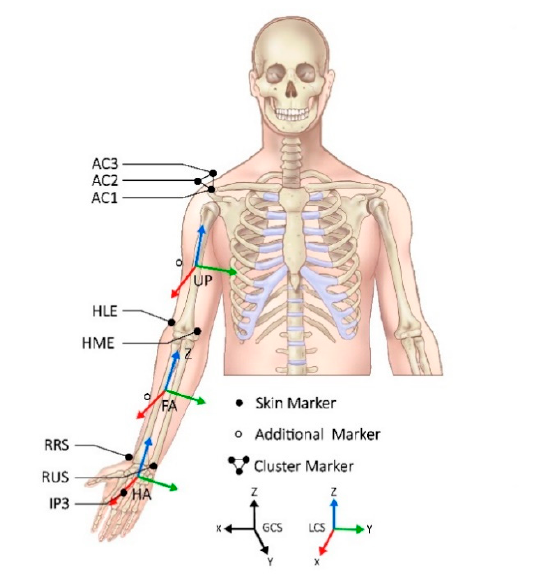
Figure 1. Reflective marker locations, local coordination systems of the upper extremity (HA, Hand; FA, Forearm; UP, Upperarm) and definition of the global coordination